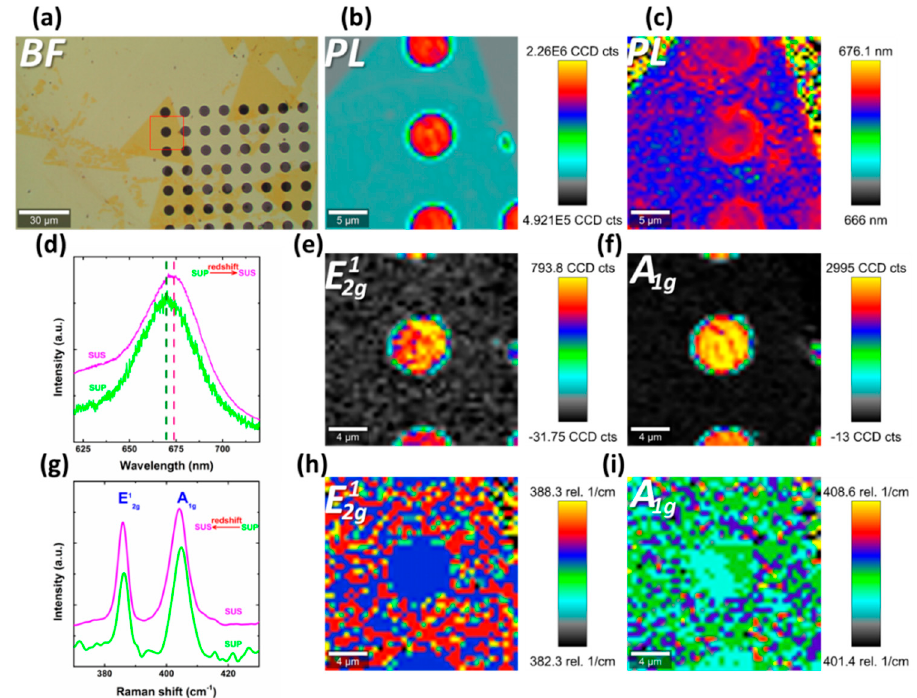
Figure 4. Free-standing monolayer MoS 2 . ( a ) Bright-field optical micrograph. Red box outlines the scanning area of the middle and right column. ( b ) PL intensity map. ( c ) PL shift map. PL and Raman spectra in ( d , g ) are normalized for clarity. ( d ) PL spectra of suspended and supported region. SUP and SUS refer to supported and suspended region, respectively. ( e , f ) Raman intensity map of E 1 and A 1g , respectively. ( g ) Raman spectra of suspended and supported region. ( h , i ) Raman shift map of E 1 and A 1g , respectively.